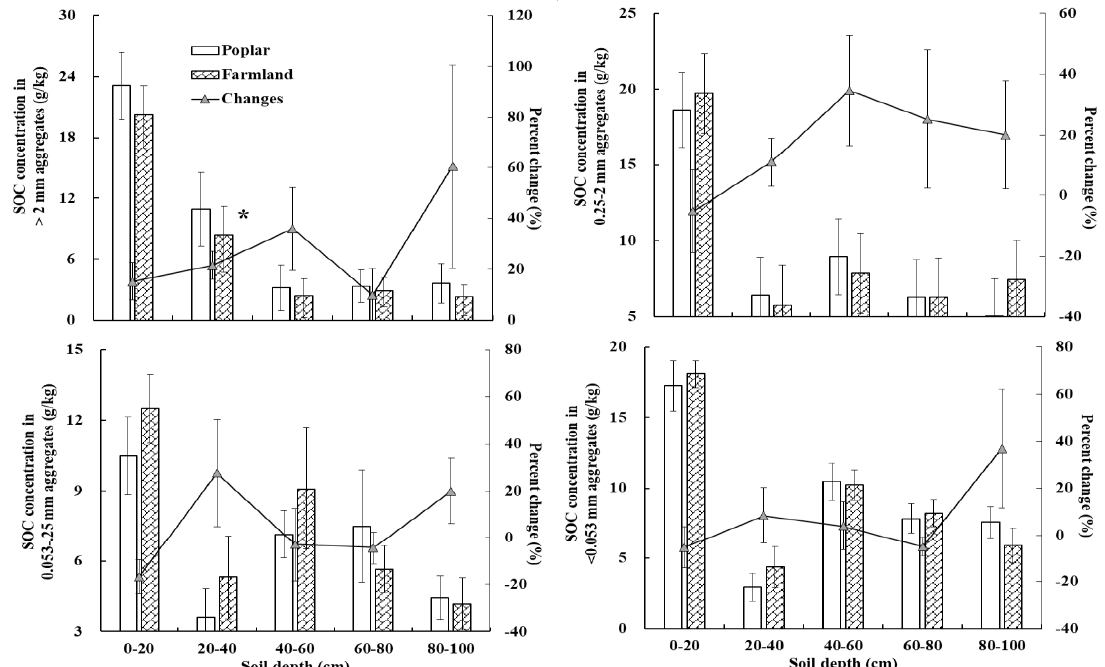
Figure 5. The effects of shelterbelt on aggregate − associated SOC concentrations in 0–20 cm, 20–40 cm, 40–60 cm, 60–80 cm, and 80–100 cm. Broken lines are percent changes of aggregate-associated SOC concentrations, * indicates the significant differences at p < 0.05 between the changes in shelterbelt − induced and farmlands in same soil layer. Error bars are the standard errors.